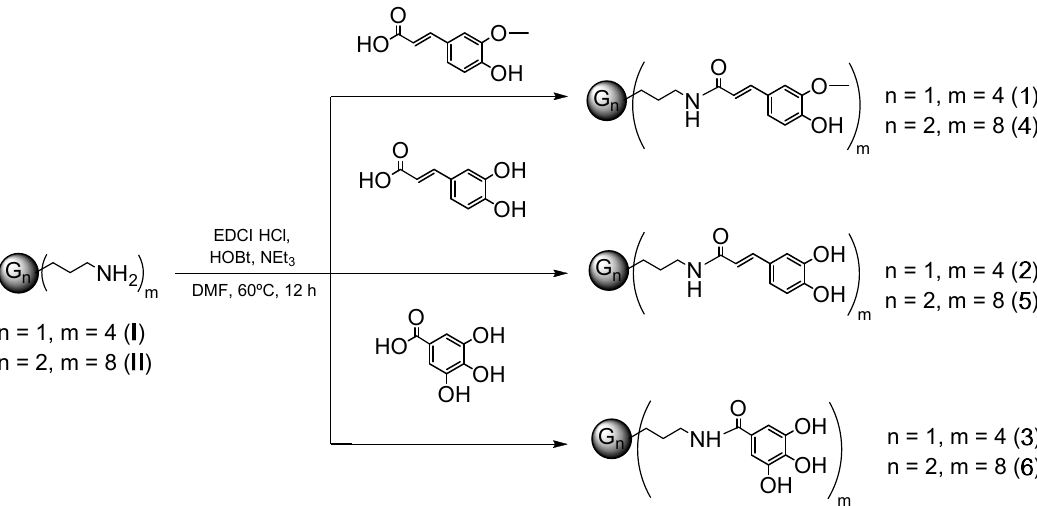
Scheme 1. Synthesis of polyphenolic dendrimers ( 1 - 6